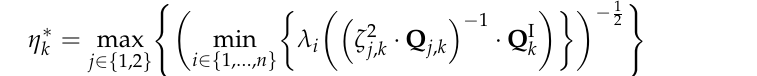
Figure 4. Intersection of an ellipsoid E 1, k with the degenerate ellipsoid E 2, k (vertical strip) with identical and different midpoints. Inner bound of the resulting thick ellipsoid: E I E O ( ∗ symbols denote the solution enclosure according to Equation (53)). ( a ) Case according to D, k Section 3.2.1 with Q 2, k according to (55). ( b ) Case according to Section 3.2.2 with the initial ellipsoid parameterization (56), (57), enclosure definition (49). ( c ) Case according to Section 3.2.2 with the initial ellipsoid parameterization (56), (57), enclosure definition